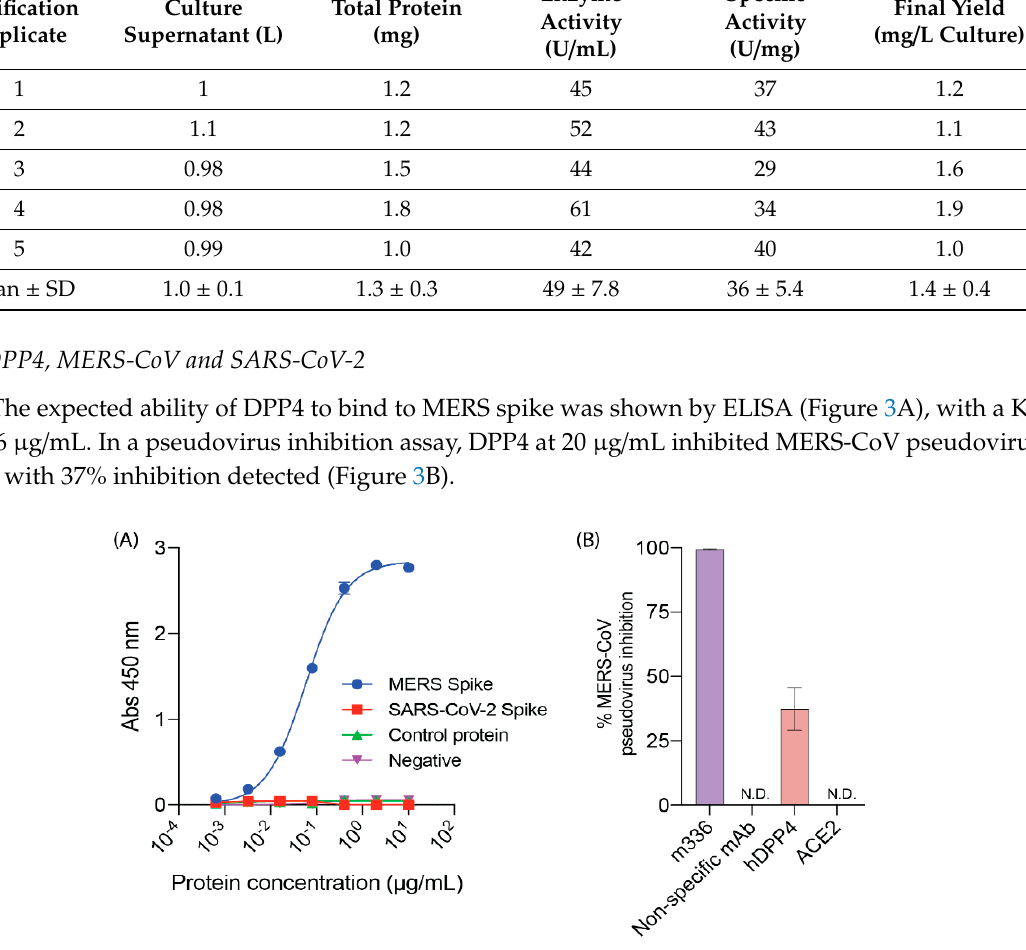
Figure 3. ELISA and virus neutralisation assays. ( A ) Purified DPP4 protein was used to capture MERS-CoV spike clamp, SARS-CoV-2 spike clamp or a control clamped protein. Clamp-stabilised proteins were detected using a clamp-specific mAb HIV1281. Data shown represent means of duplicate values. ( B ) DPP4, ACE2, a MERS-specific mAb m336 or a non-specific mAb C05 were used at 20 µg/mL and incubated with MERS-CoV pseudovirus. Percent MERS-CoV inhibition is the percentage reduction in luciferase signal (RLU) compared to virus-only control. N.D. indicates no inhibition detected. Data shown are the mean of duplicate values with error bars representing SD.